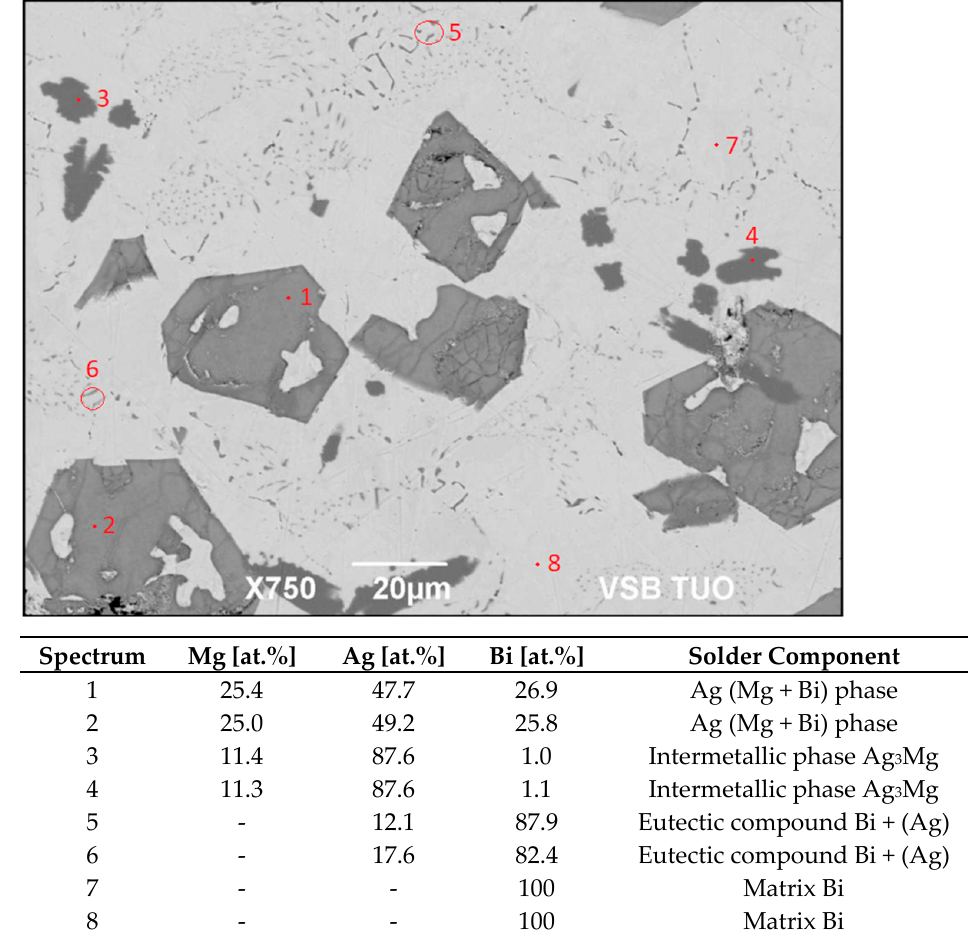
Figure 9. Microstructure of the Bi11Ag1Mg solder.